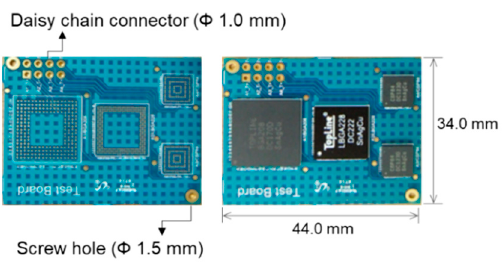
Figure 2. Test vehicle and supporting fixture.